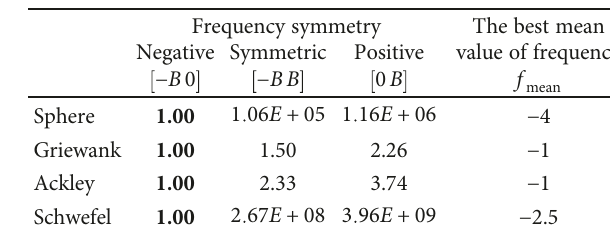
Table 3: The mean normalized value of the performance J mean for the benchmark function for di ff erent bounds of frequency and the best found mean values of the